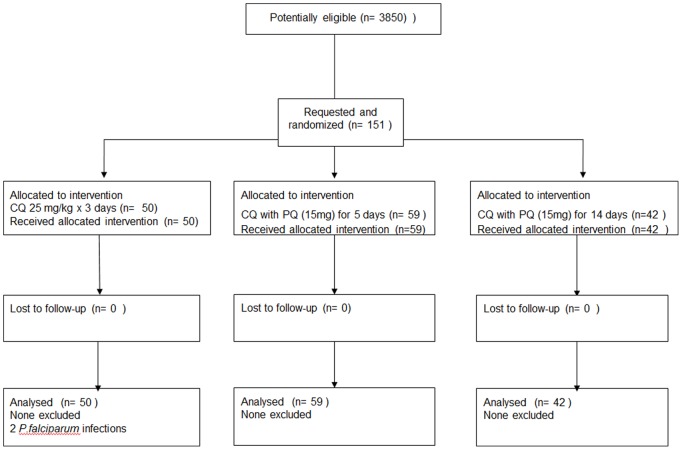
CONSORT flow chart.